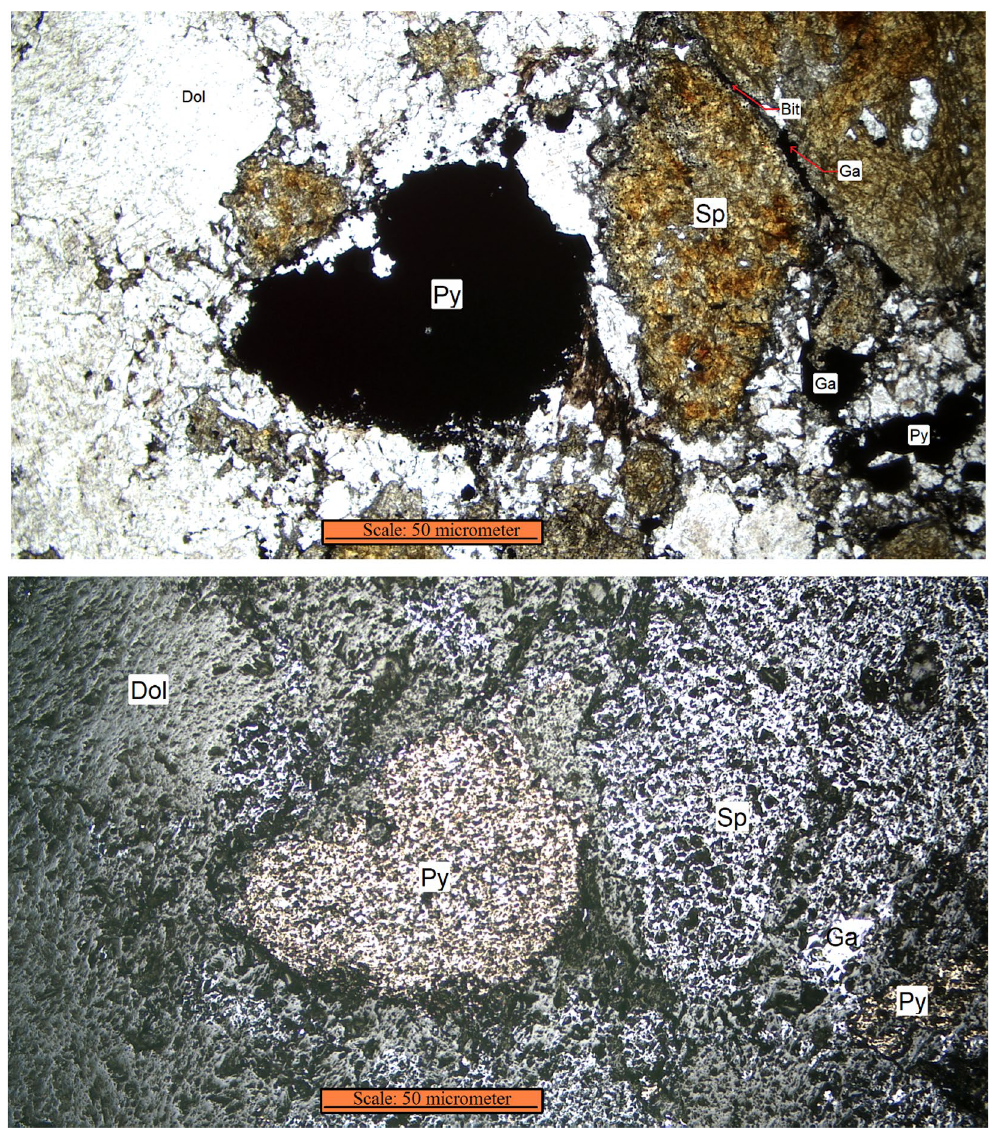
Figure 3. Microscopic image of a thin section from a fragment of Gushfil ore, transmitted image (up), reflected image (down). The showed minerals are sphalerite (Sp), galena (Ga), pyrite (Py), dolomite (Do), bitumen